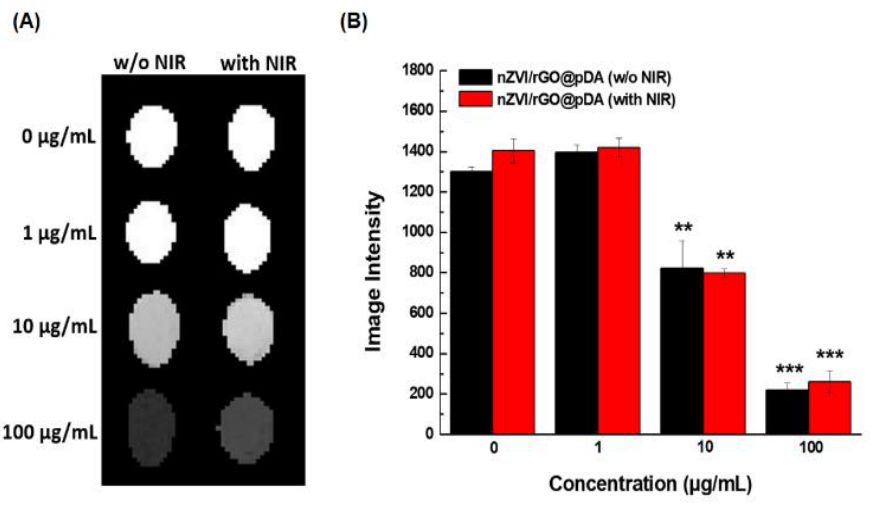
Figure 8. Analysis of magnetic resonance imaging contrast of nano zero-valent iron immobilized on the surface of reduced graphene oxide then modified with dopamine. ( A ) T 2 -weighted MRI of nZVI / rGO@pDA preparations (1–100 µ g / mL) with / without near infrared NIR illumination. ( B ) Bar graph of the MRI signal intensities of nZVI / rGO@pDA (1–100 µ g / mL) with / without NIR illumination. Key: ** p < 0.01 and *** p < 0.001 compared with the control. All experiments were performed three times independently. Abbreviations: GO, graphene oxide; nZVI / GO, reduced graphene oxide modified with dopamine; nZVI / rGO@pDA, nano zero-valent iron immobilized on the surface of reduced graphene oxide then modified with